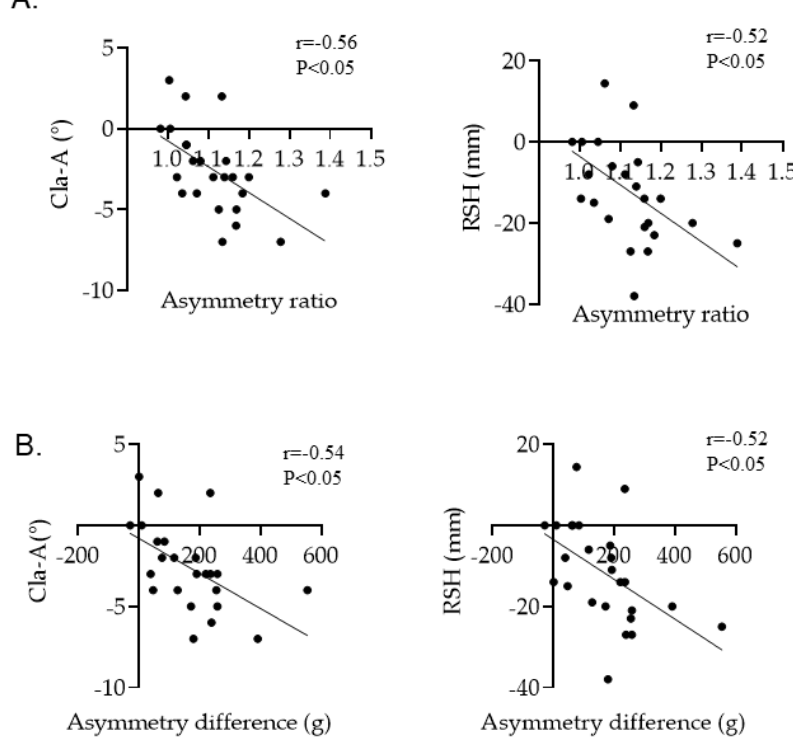
Figure 3. ( A ) Correlation between Cla-A, RSH, and asymmetry ratio in the Lenke1A group, ( B ) Correlation between Cla-A, RSH, and asymmetry difference in the Lenke1A group.